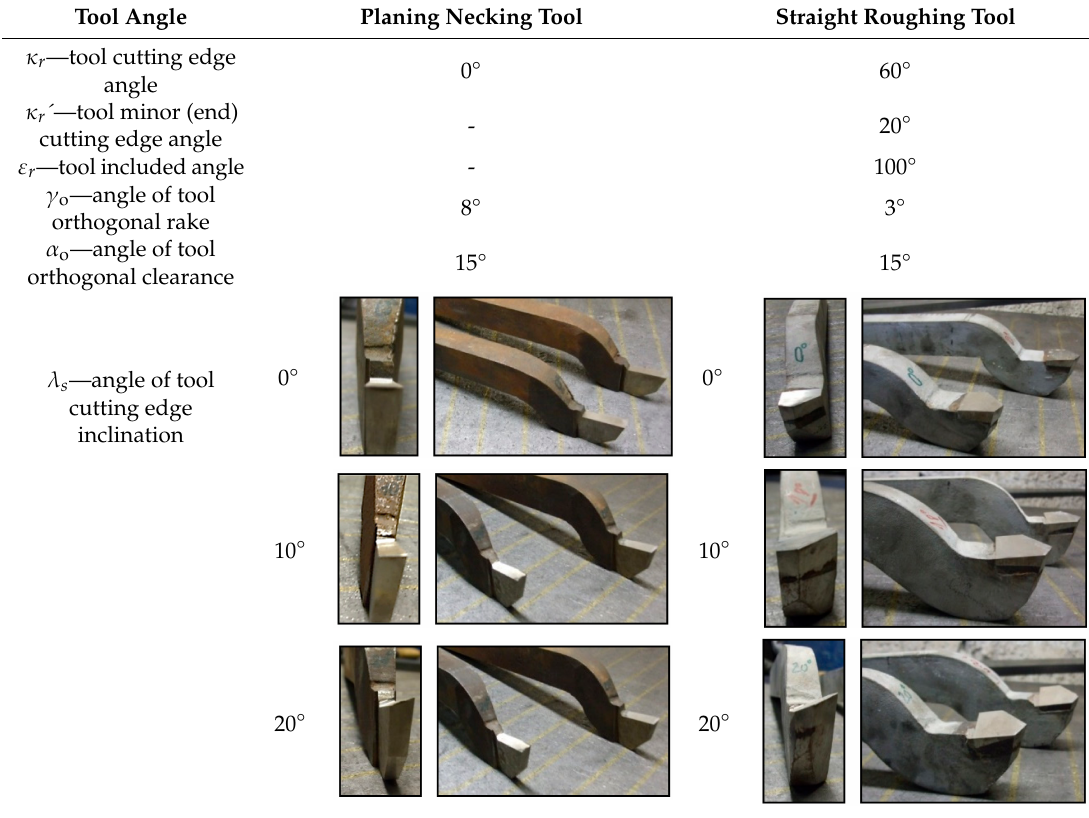
Table 1. Cutting tools and their geometries as used in the experimental study. Tool Angle Planing Necking